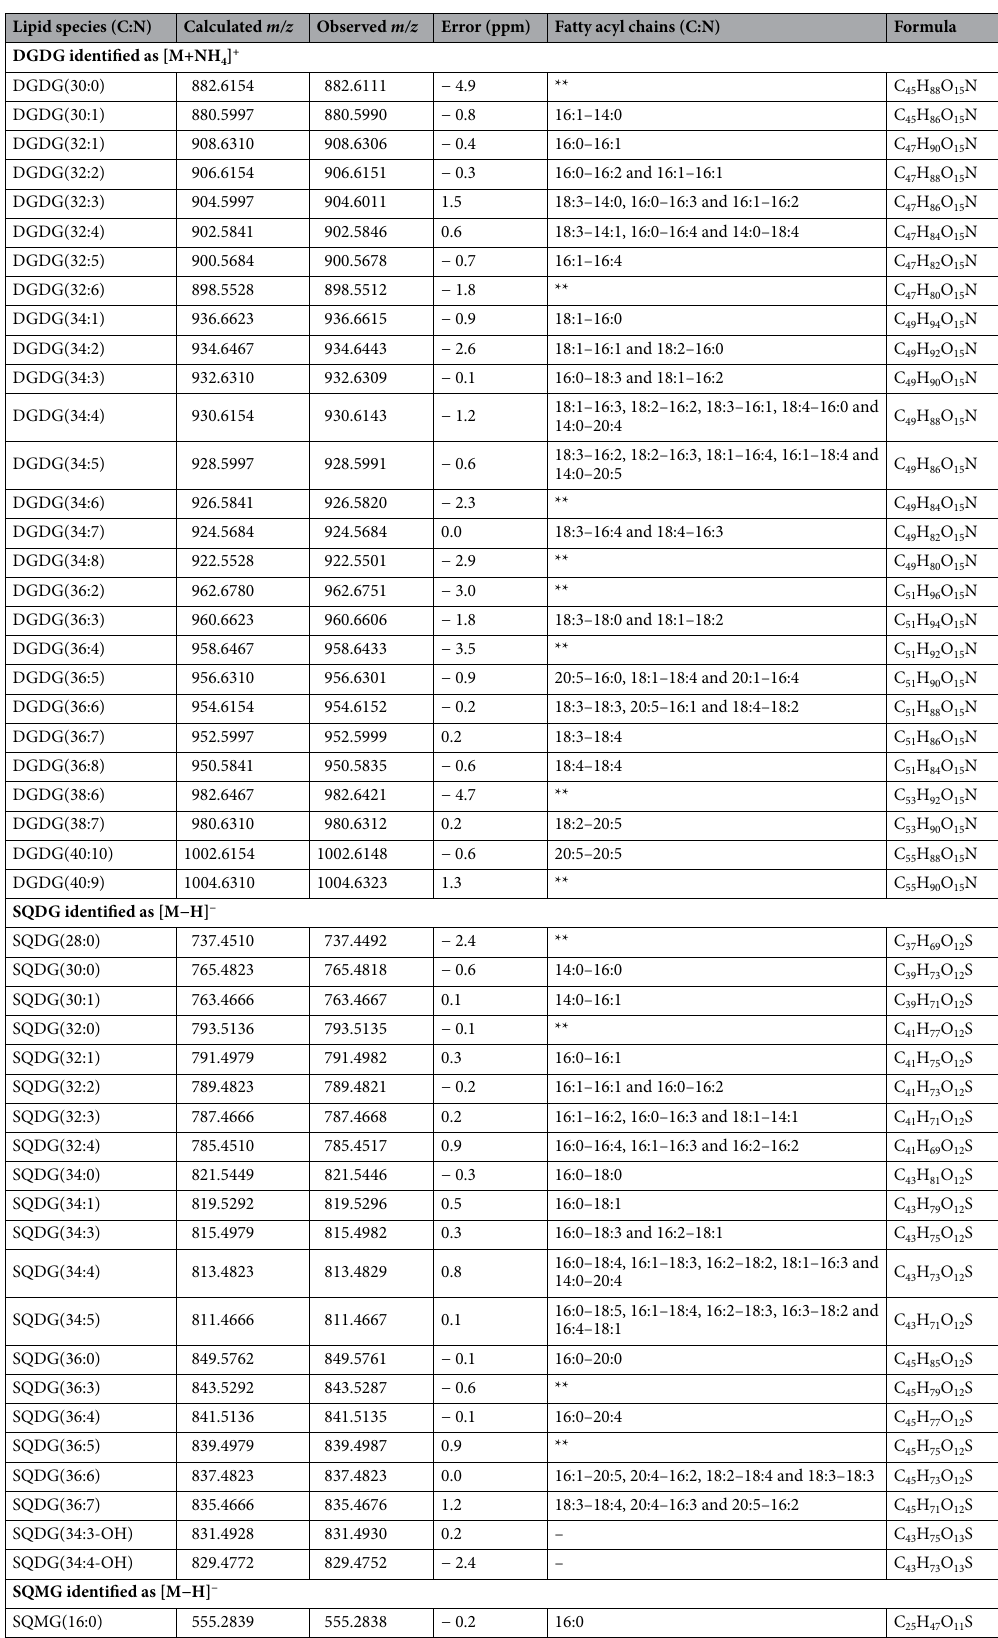
Table 5. Glycolipids identified in the polar lipidome of Chlorococcum amblystomatis by HILIC–HR–ESI–MS and MS/MS . C carbons, N number of double bonds. *Identified based on the polar head fragment, calculated mass and retention time. **Identified based on calculated mass and retention